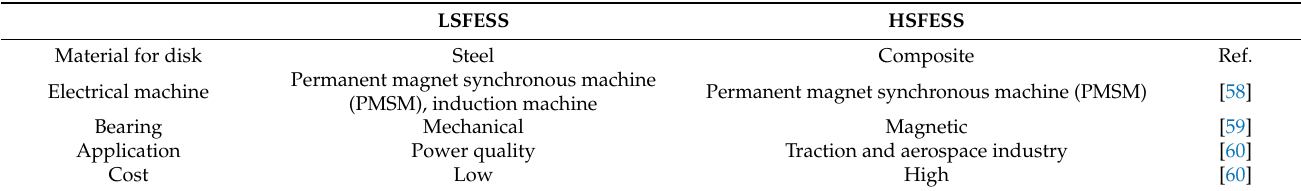
Table 2. Comparison between high-speed flywheel energy storage system (HSFESS) and low-speed flywheel energy storage system (LSFESS).